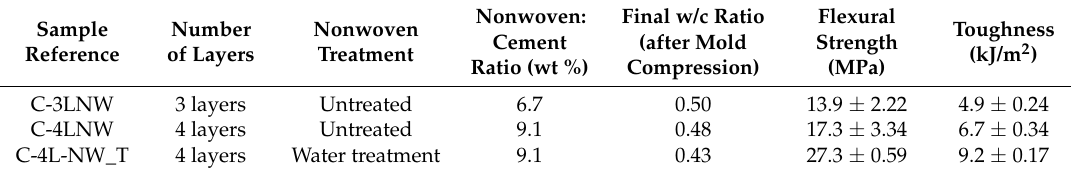
Table 1. Sample reference, composition, and values of flexural strength and toughness of the composites prepared to analyze the effect of number of layers and the water treatment of the nonwoven fabrics.